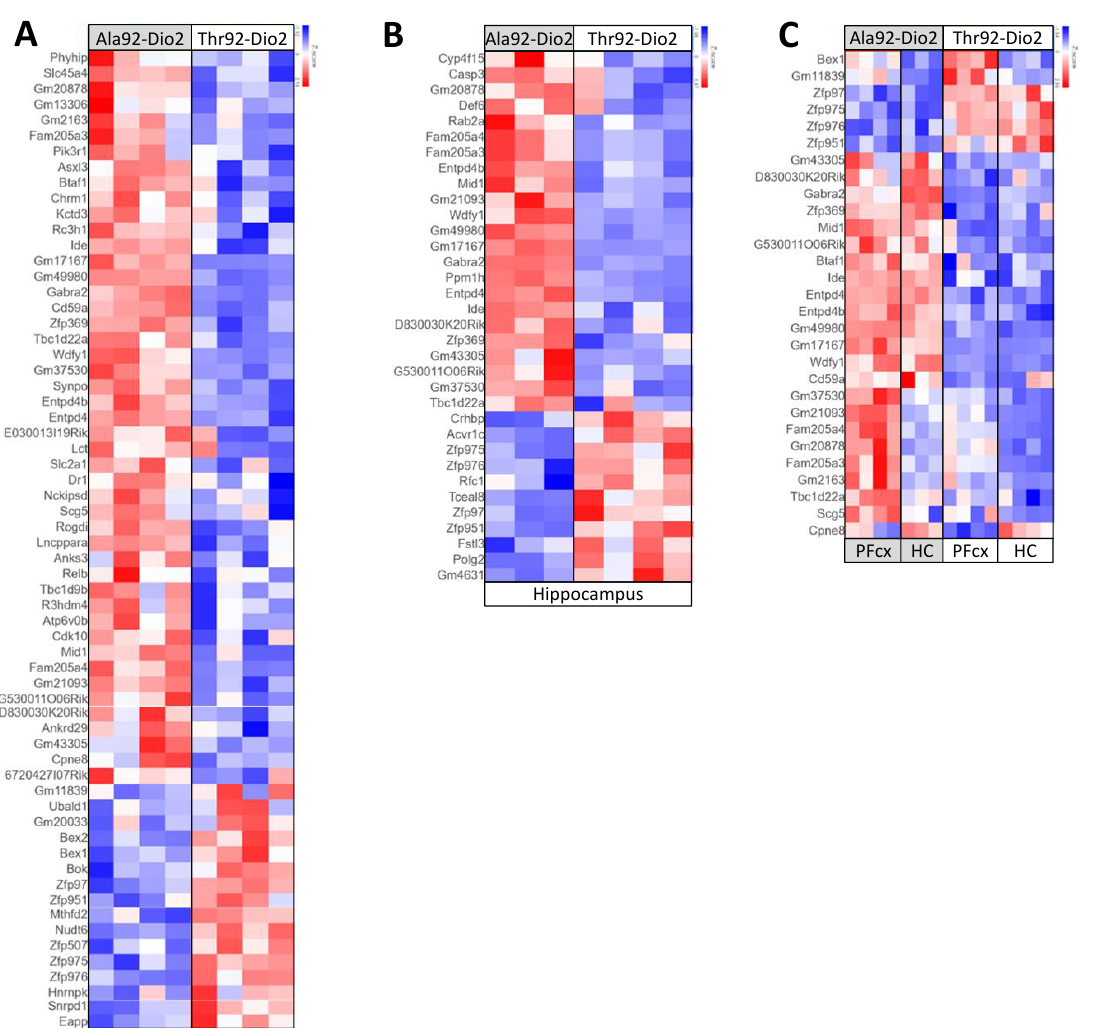
Figure 4 Figure 4. Heat map of genes from Ala92-Dio2 mice shown in Figure 3. ( A ) heat map of 63 genes